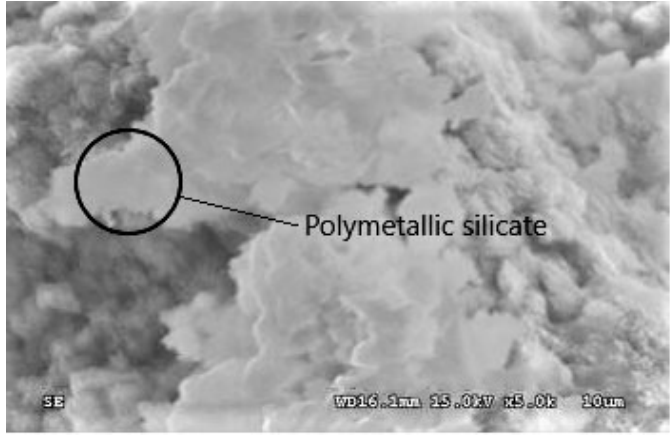
Figure 16. GA5 paste SEM in 5000 k image.